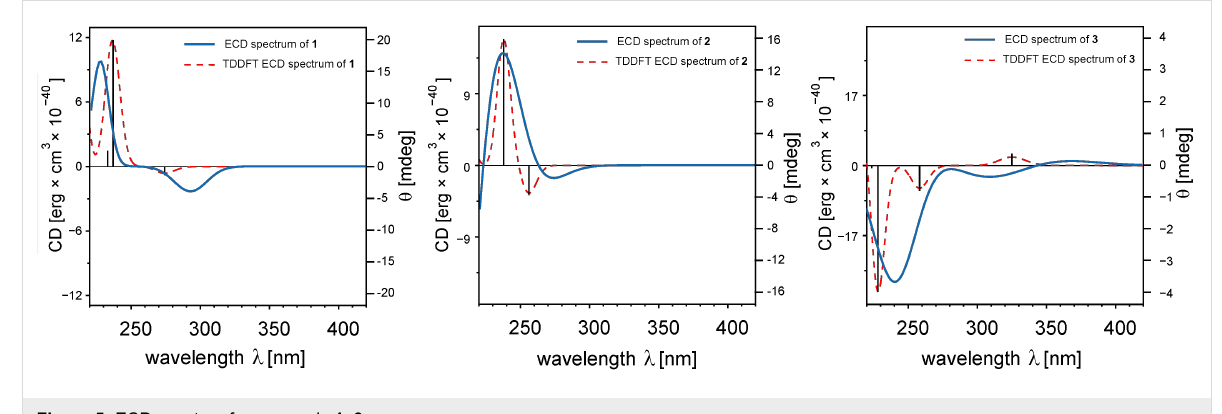
Figure 5: ECD spectra of compounds 1 – 3 .